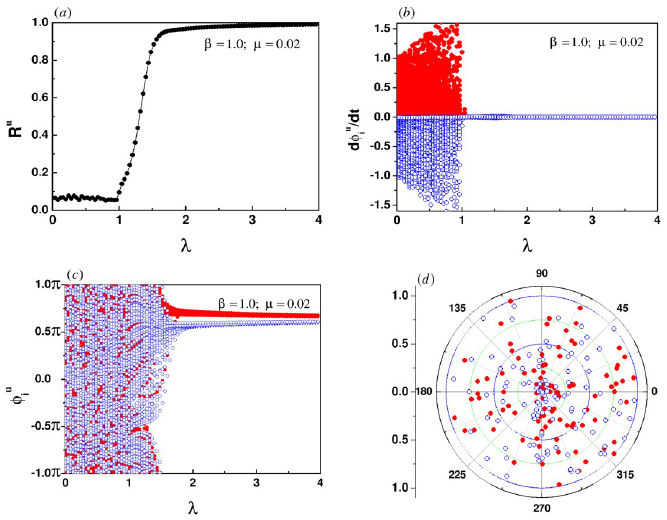
Fig 10. (a) The evolution of order parameter of the upper layer for the linear correlation. (b) and (c) show the evolutions of instantaneous frequencies and phases of the oscillators, respectively. (d) is the snapshot of instantaneous phases at λ = 1.0. The intra-layer coupling strength is set to 0.02. The red solid circles represent the oscillators with positive natural frequencies, while the oscillators with negative natural frequencies are described by blue hollow circles.